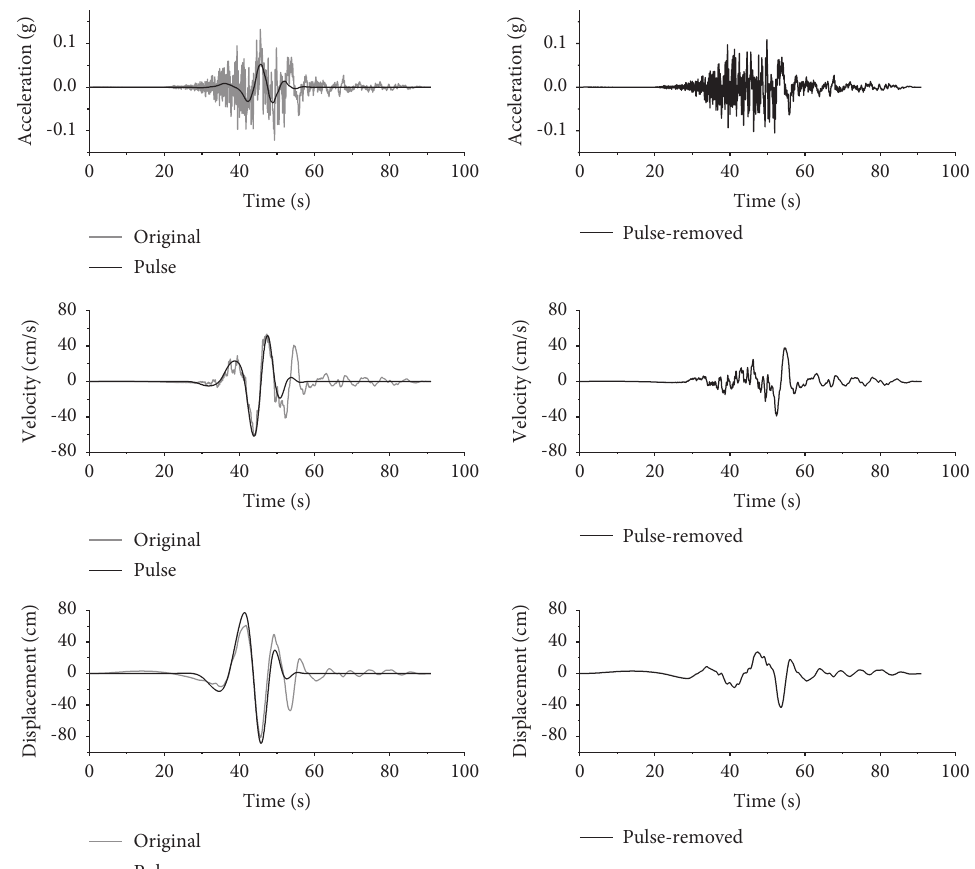
Figure 3: Time histories of the original ground motion, the extracted pulse, and the pulse-removed part of the ground motion recorded at TCU102 station during the 1999 Chi-Chi